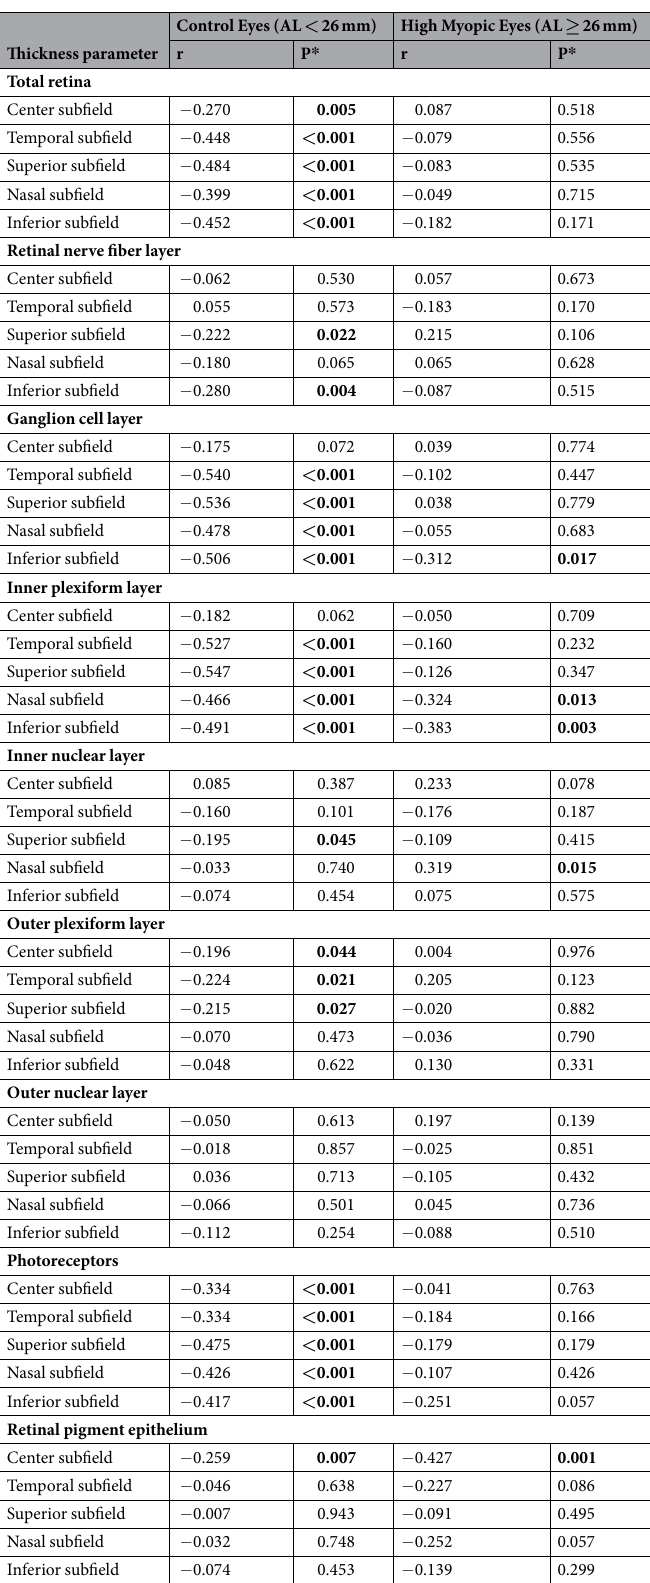
Table 4. Effect of age on individual retinal layer thicknesses and axial length prolongation after ocular magnification adjustment by correlation analysis. AL, axial length. P values were yielded by partial correlation analysis (Pearson correlation) after adjusting for sex to evaluate the effect of age on macular thickness in each other group (r = partial correlation coefficients). * Bold values indicate statistically significant differences (P <